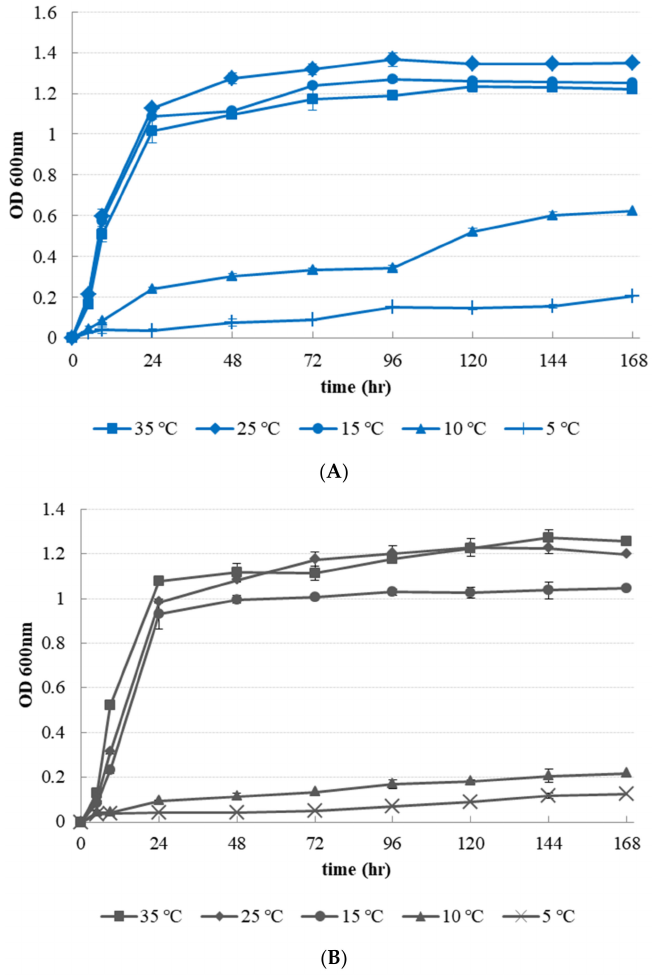
Figure 2. Growth of Latilactobacillus curvatus PD1 and Leuconostoc mesenteroides PD2 at different temperature conditions in MRS broth with lactose (2%, w/v ) for 7 days: ( A ) L. curvatus PD1 ( B ) L. mesenteroides